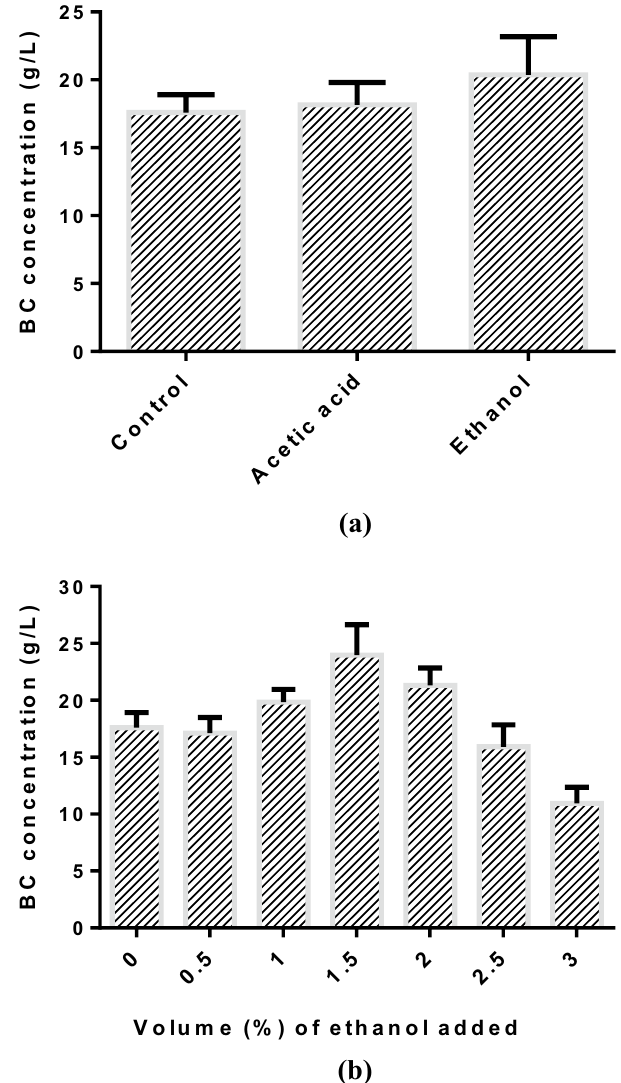
Figure 8. ( a ) screening of supplement; ( b ) effect of supplement concentration on BC concentration ((inoculum size: 5%, v/v, fermentation time: 15 d; initial pH = 5.5; Nitrogen source: Yeast extract; C/N ratio: 40).